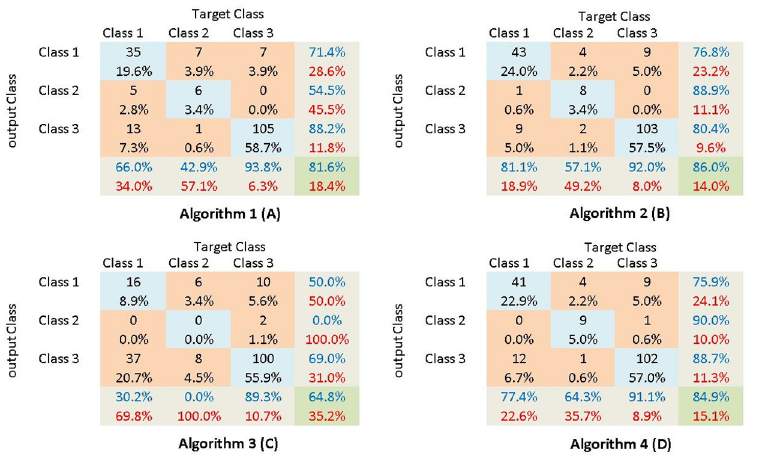
confusion matrices were obtained. In the given matrices Class 1 represents the fetal movement realizations, Class 2 represents the maternal laugh realizations and Class 3 represents the maternal respiratory movement realizations. And confusion matrices obtained by implement- ing the four algorithms are shown in Fig 15.